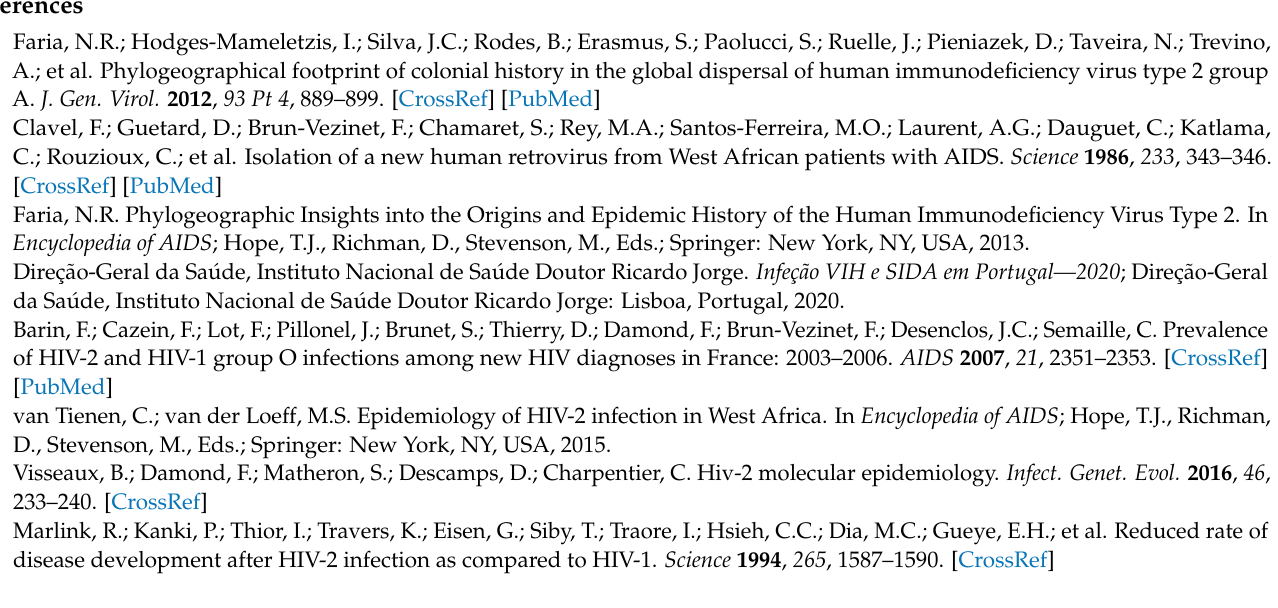
infected patients from which the viruses were isolated. Table S2: Hill slope values for all drugs and isolates. Table S3: Inhibitory concentration 50% (IC 50 ) and IC 50 fold-change of RAL, DTG, BIC, and BSS-730A against primary HIV-2 isolates from RAL-naïve and RAL-experienced patients. Table S4: PCR integrase primers. Table S5: Inhibitory concentration 90% (IC 90 ) and IC 90 fold-change of RAL, DTG, BIC, and BSS-730A against primary HIV-2 isolates from RAL-naïve and RAL-experienced patients. Table S6: Instantaneous Inhibitory Potential (IIP) values for all isolates and